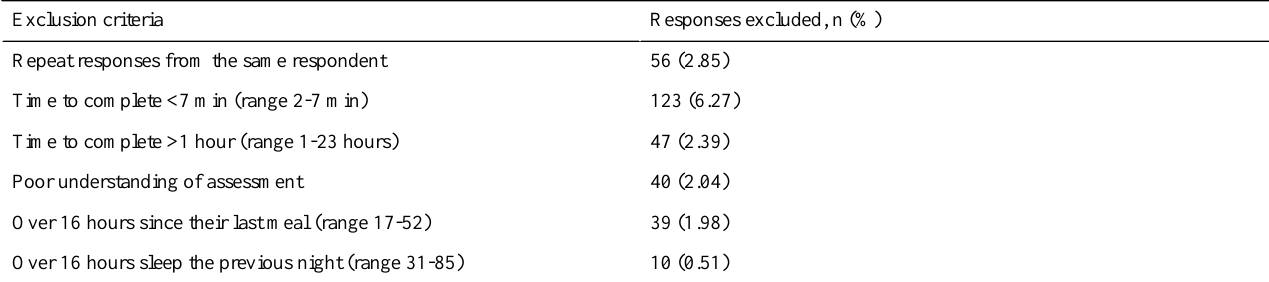
Table 2. A breakdown of the percentage of responses excluded for each exclusion criterion (N=1961).